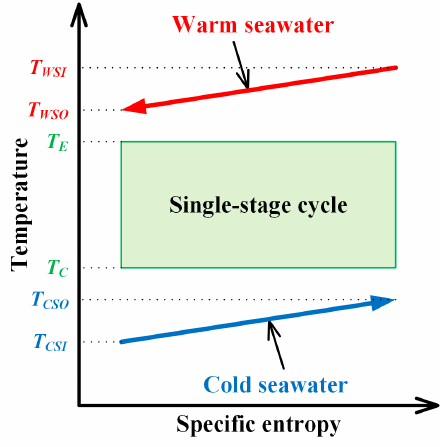
Figure 2. Conceptual T-s diagram of Rankine cycle.